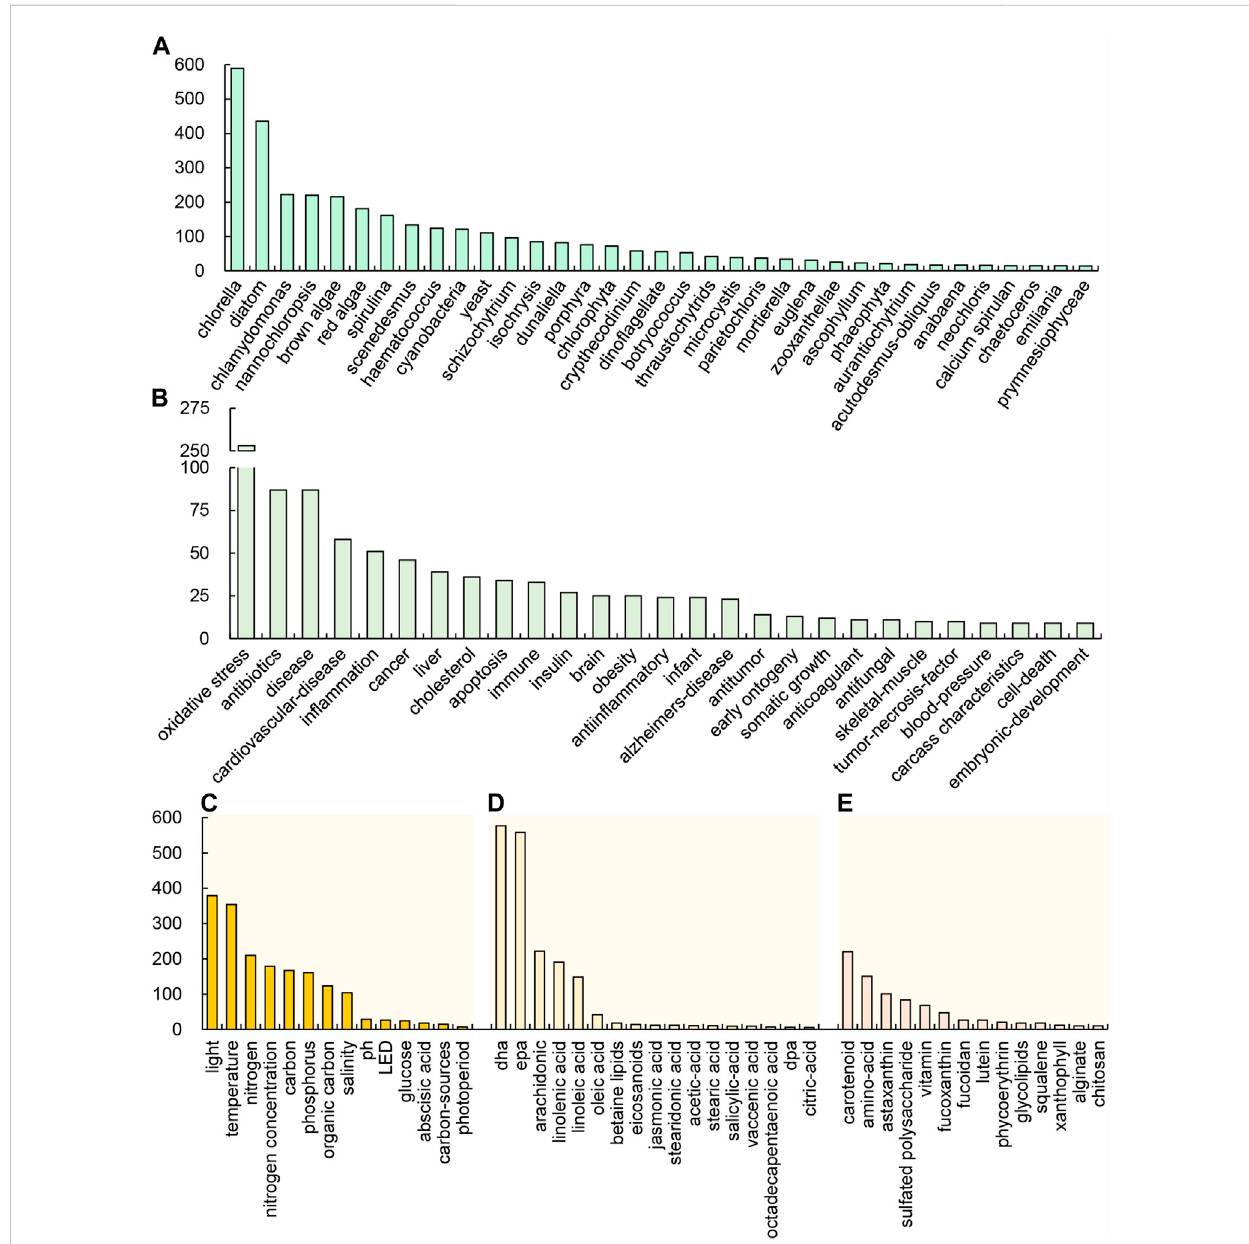
FIGURE 3 Occurrence ofthe main keywords inthereports of algae-PUFA according to thespecies (A) , health functions (B) , conditions (C) , kinds of PUFAs (D) , other high value products (E) .